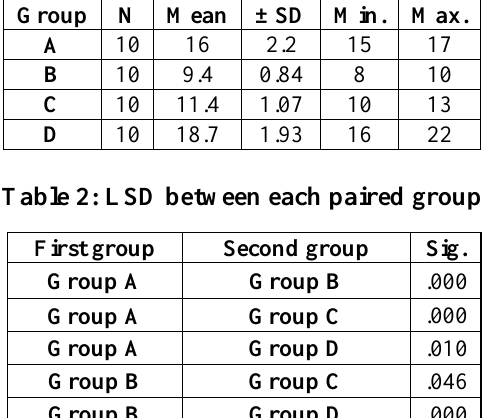
Table 1: The Descriptive statistics of the experimental groups